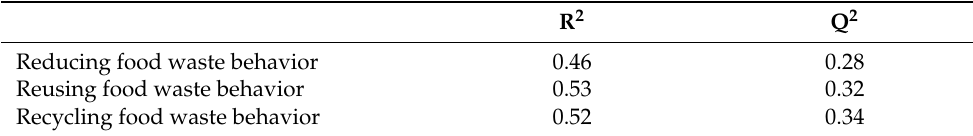
Table 7. Analysis of R 2 and Q 2